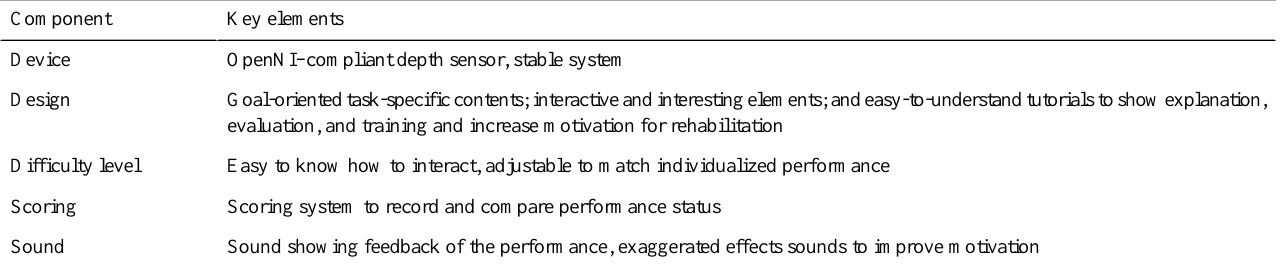
Table 1. Key elements of a depth camera–based, task-specific virtual reality rehabilitation game [37]. Key elementsComponent